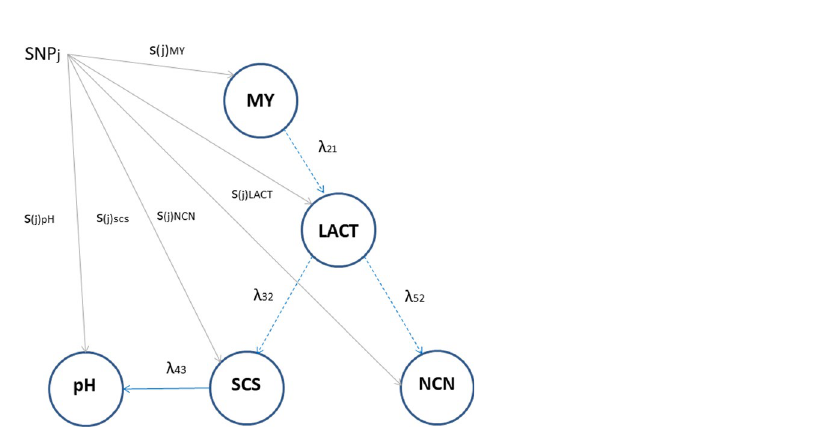
Figure 2. A scheme for path analysis of SNP effects for five milk-related traits. MY: milk yield; pH: milk pH; LACT: lactose; SCS: somatic cell score; NCN: casein (expressed as % of total milk N). The blue arrows indicate the direction of relationship according to the learned causal structure. Dashed lines correspond to a negative path coefficient.